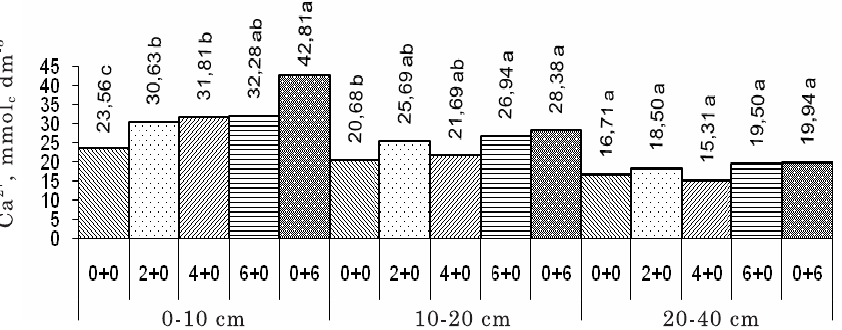
Figura 2. Teores de Ca 2+ no solo para a interação Tratamentos x Profundidades. Valores acompanhados de mesma letra, dentro de profundidade, não diferem estatisticamente entre si pelo teste de Tukey.